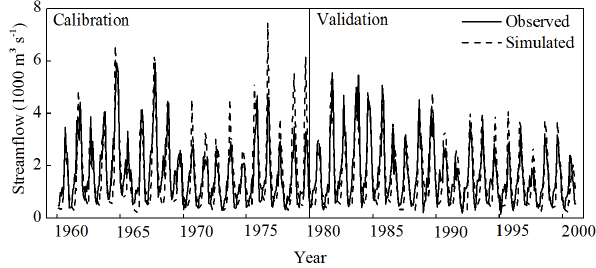
Fig. 3. Monthly comparisons between the SWAT-simulated stream- flow and observed naturalized streamflow in the calibration (1960– 1979) and validation (1980–2000) periods at the Huayuankou sta- tion. The vertical line divides the calibration and validation periods.